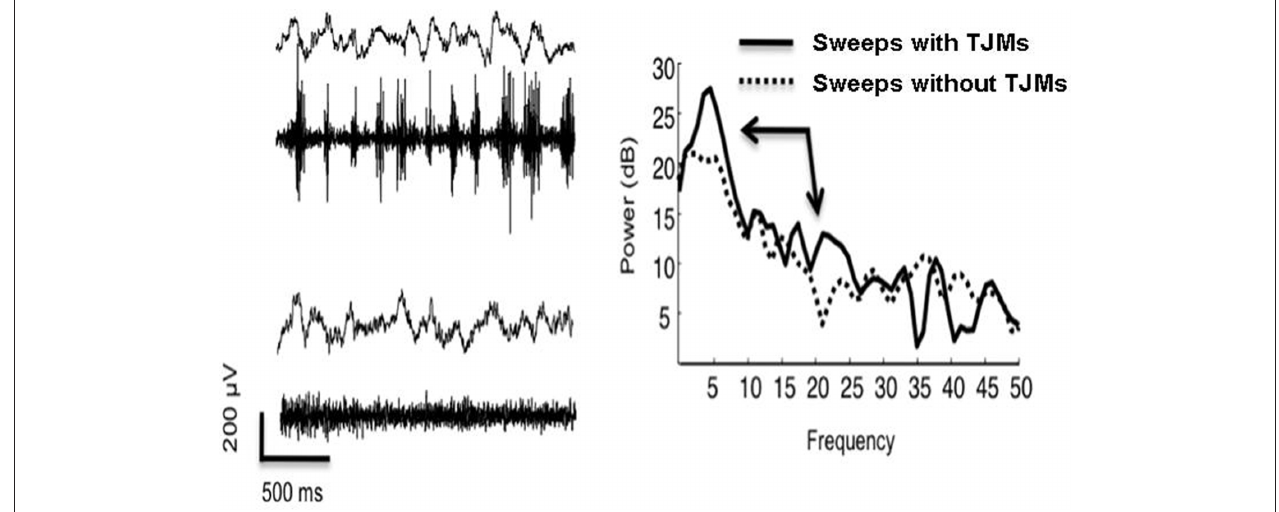
indicate prominent increase in power in 5–8 Hz band as well as a broad increase in beta band “15–30” Hz activity (see arrows). Note increased frequency and regularity of ∼ 5 Hz signal in traces with rhythmic EMG activity as compared to slower and less regular LFP traces in absence of rhythmic EMG activity.